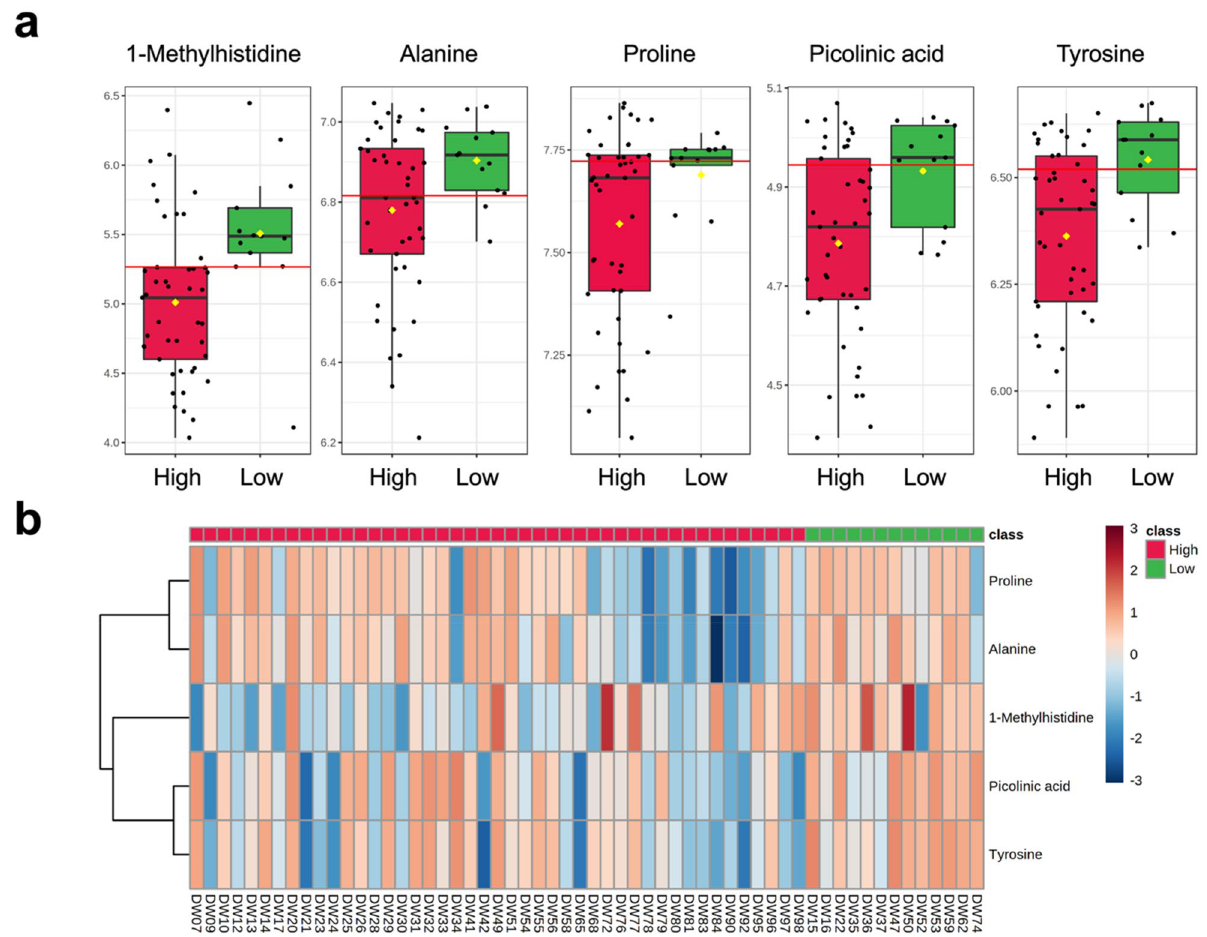
Figure 6. Significant metabolites between high and low screen time groups as determined by GLM with FDR correction. ( a ) Box plots of significant metabolites between groups showing normalized relative abundance. Age, sex, BMI, and MVPA were controlled for as covariates: 1-Methylhistidine ( q = 0.002), Alanine ( q = 0.020), Proline ( q = 0.024), Picolinic acid ( q = 0.034), Tyrosine ( q = 0.048). Yellow diamonds signify group means, while horizontal red lines signify optimal between-group cut-offs. ( b ) Heatmap of significant metabolites by screen time